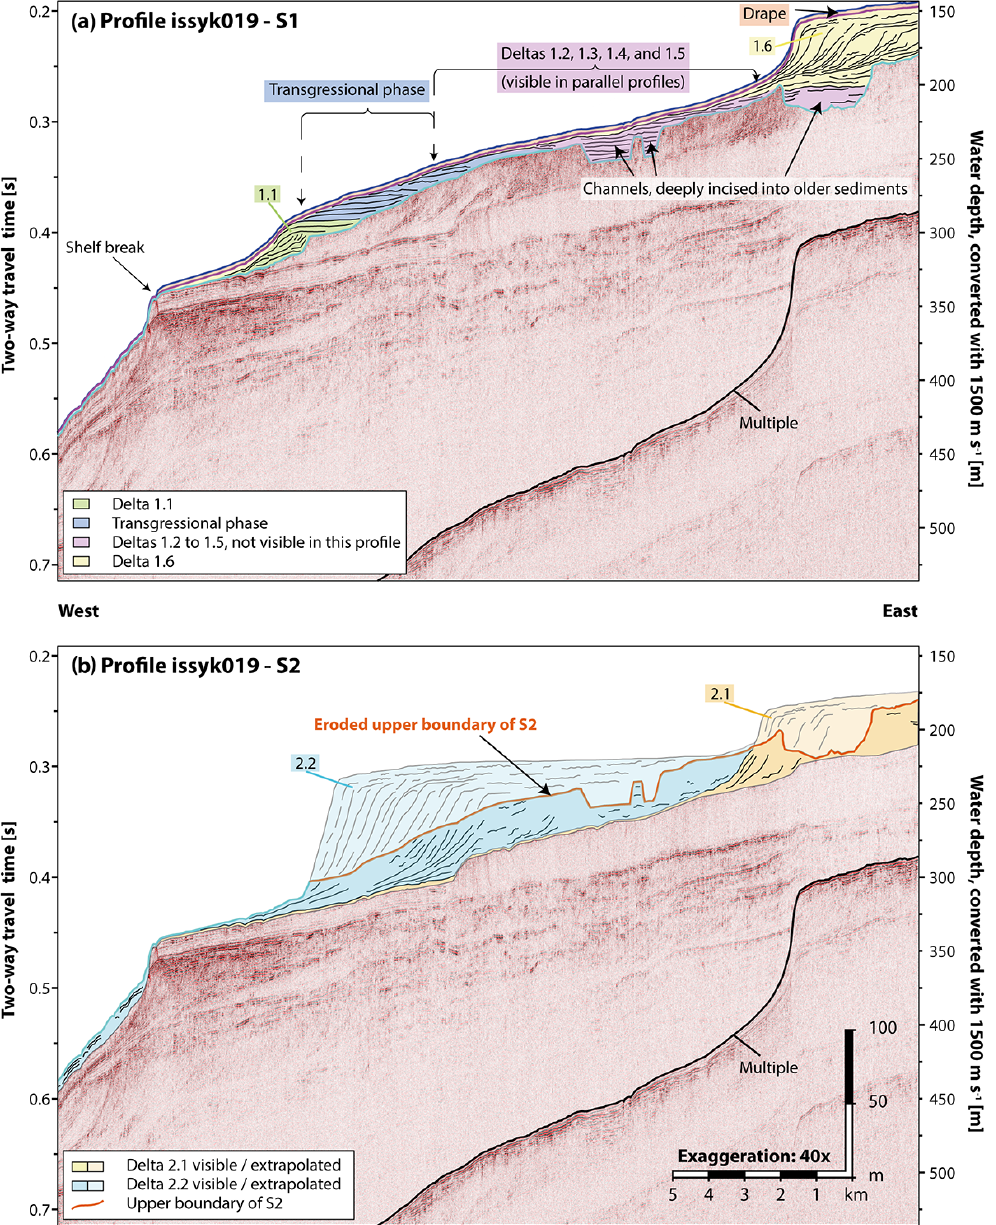
Figure 8. Sequences 1 and 2 on seismic profile issyk019. Upper panel: sequence 1 with distinct deltas 1.1 and 1.6 and the transgressional phase. Deltas 1.2 to 1.5 are only visible in parallel profiles, but their relative location is marked. Note that the lower boundary of Sequence 1 is highly erosive with deeply incised channels. Lower panel: sequence 2. The missing (eroded) parts of deltas 2.1 and 2.2 are tentatively completed in light colors for better visualization. Seismic data overlaying the respective sequences are